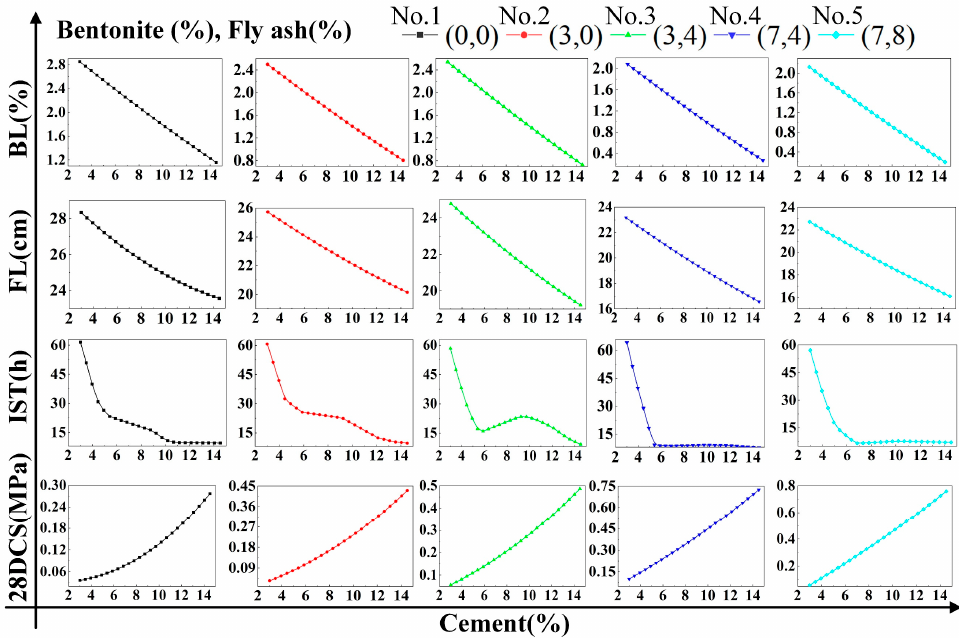
Figure 21. In fl uence of CE content on DWS-GM. Figure 21. Influence of CE content on